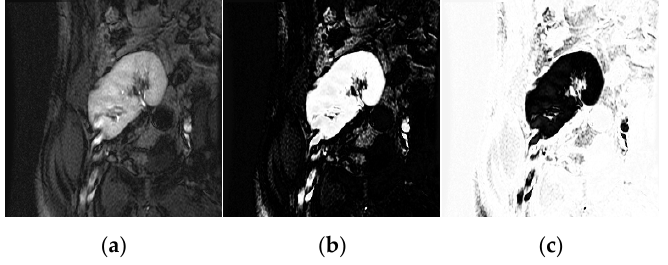
Figure 5. Segmentation by the FCMC algorithm of a DCE-MRI image. Column ( a ) depicts input kidney. Columns ( b ) and ( c ) show the output kidney and background clusters, respectively.